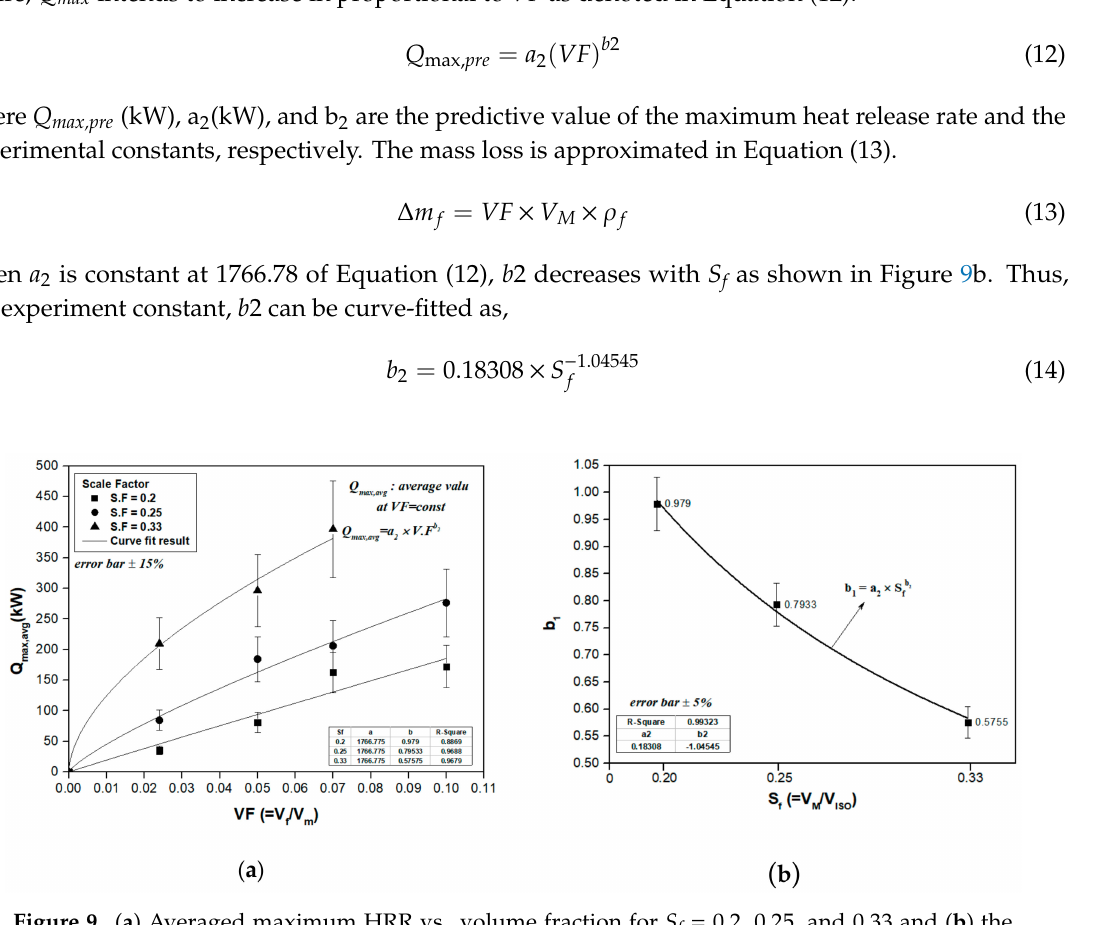
Figure 9. ( a ) Averaged maximum HRR vs. volume fraction for S f = 0.2, 0.25, and 0.33 and ( b ) the curve-fit results of experiment coe ffi cient b1 vs. scale factor for S f = 0.2, 0.25, and